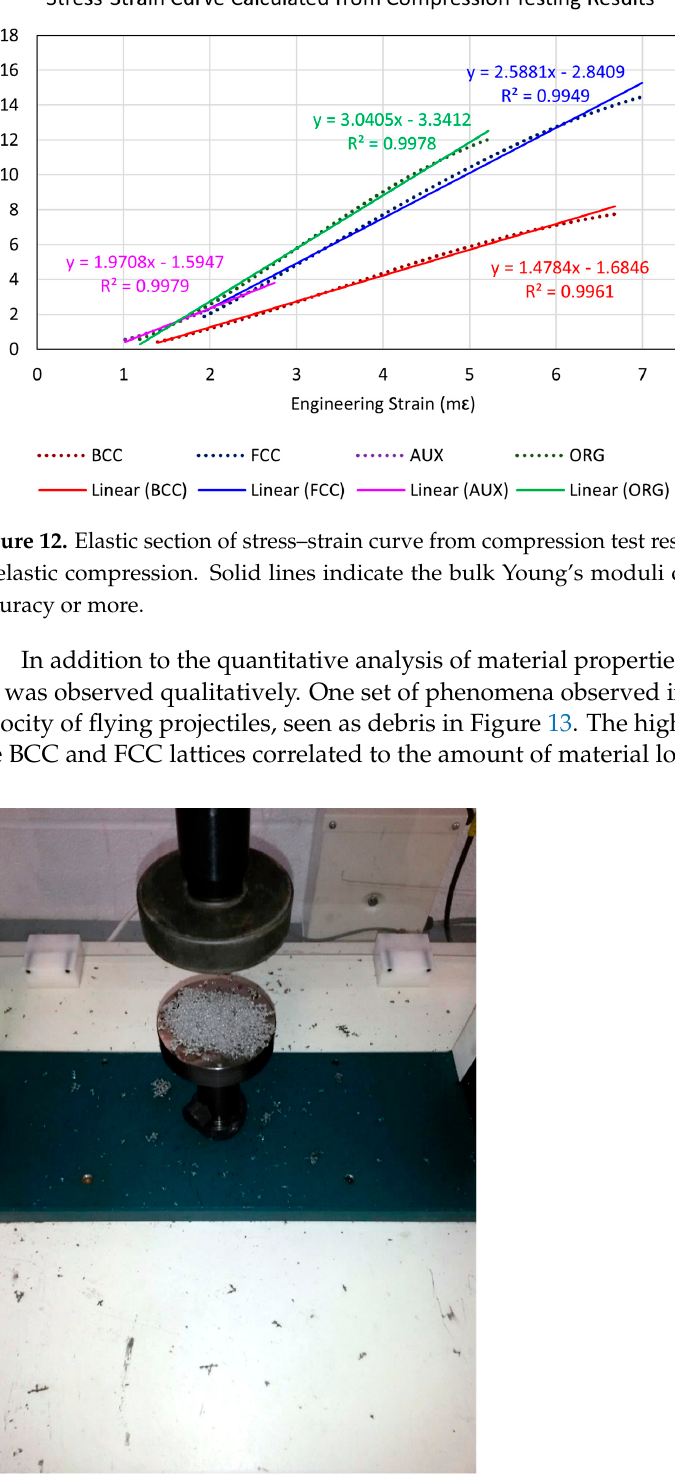
Figure 13. The image shows crushed debris from the FCC lattice around machine jigs after compres- sion.